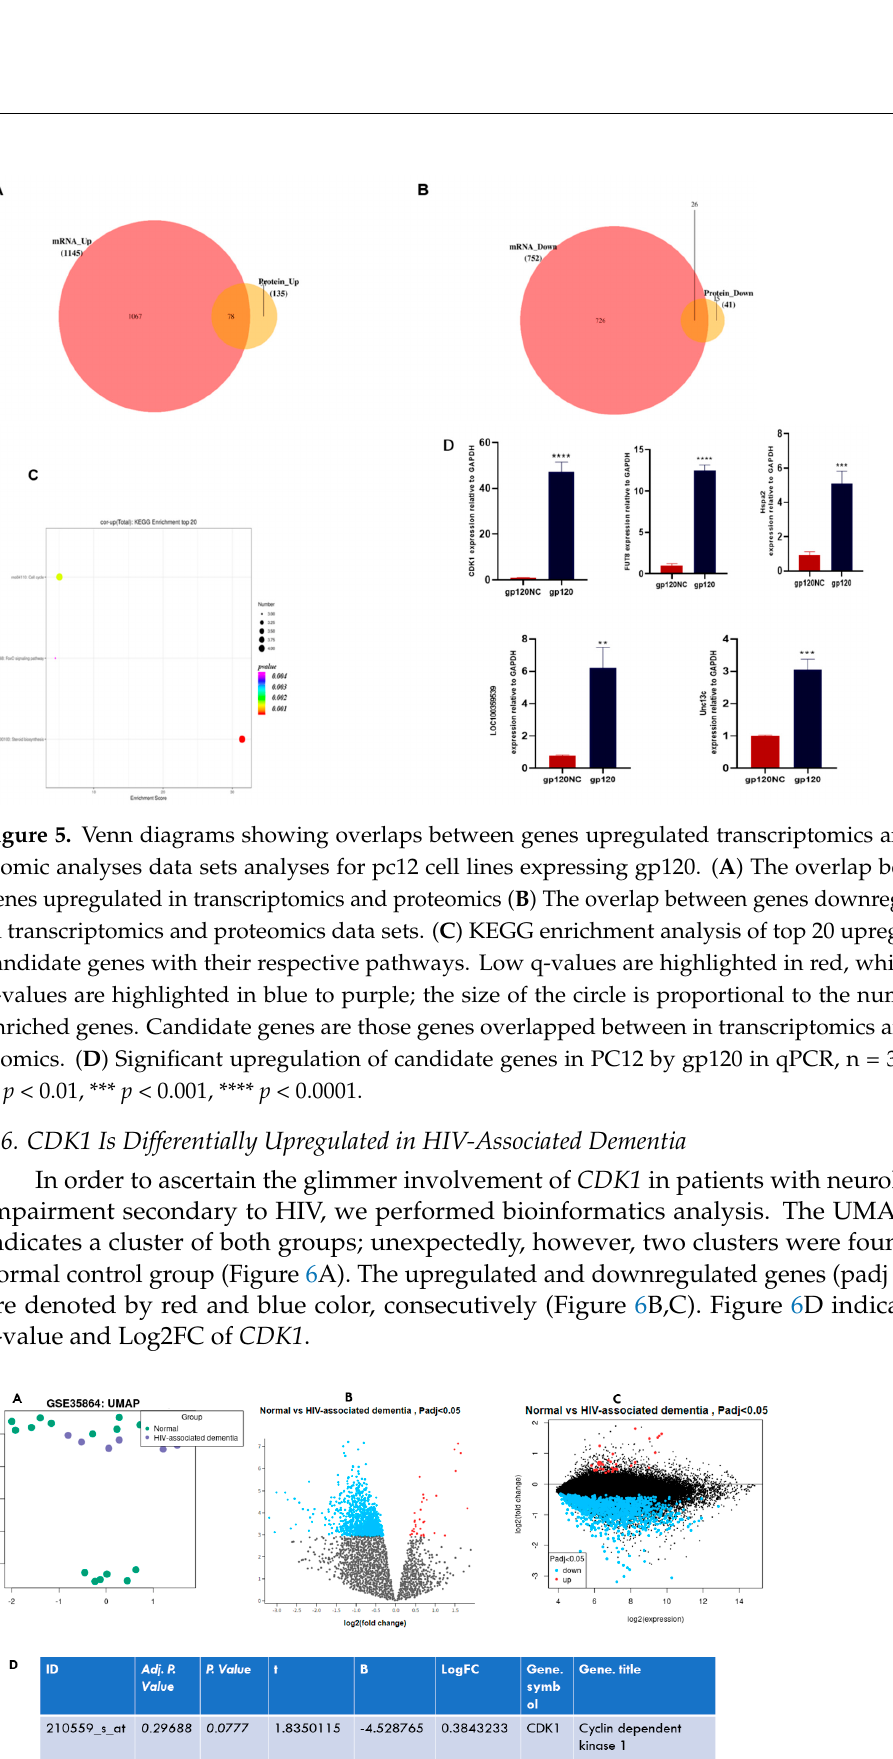
Figure 6. CDK1 in HIV-associated dementia. ( A ) The Uniform Manifold Approximation and Projec- tion plot (UMAP), ( B ) Volcano plot, and ( C ) Mean-difference plot. ( D ) indicates the p -value and the Log2FC of CDK1 in HIV-associated dementia against the normal